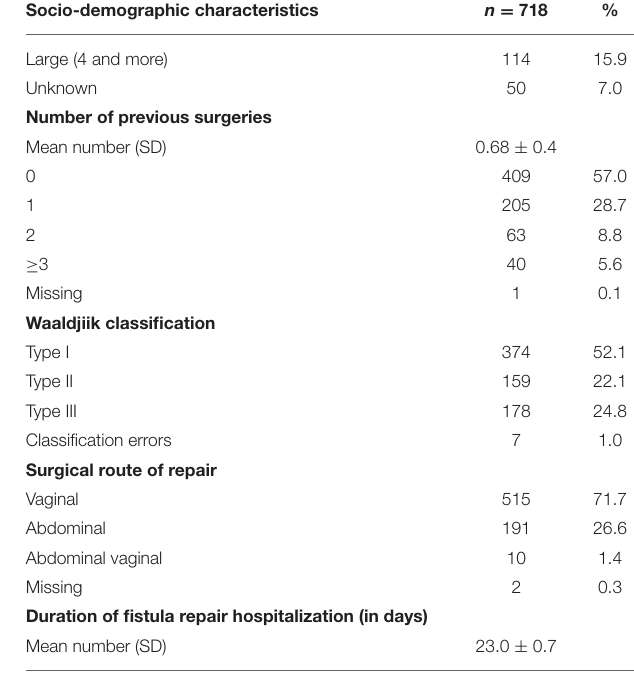
TABLE 2 | Sociodemographic and clinical characteristics of patients who underwent fistula repair in sites supported by the Fistula Care Plus project in the Democratic Republic of Congo,